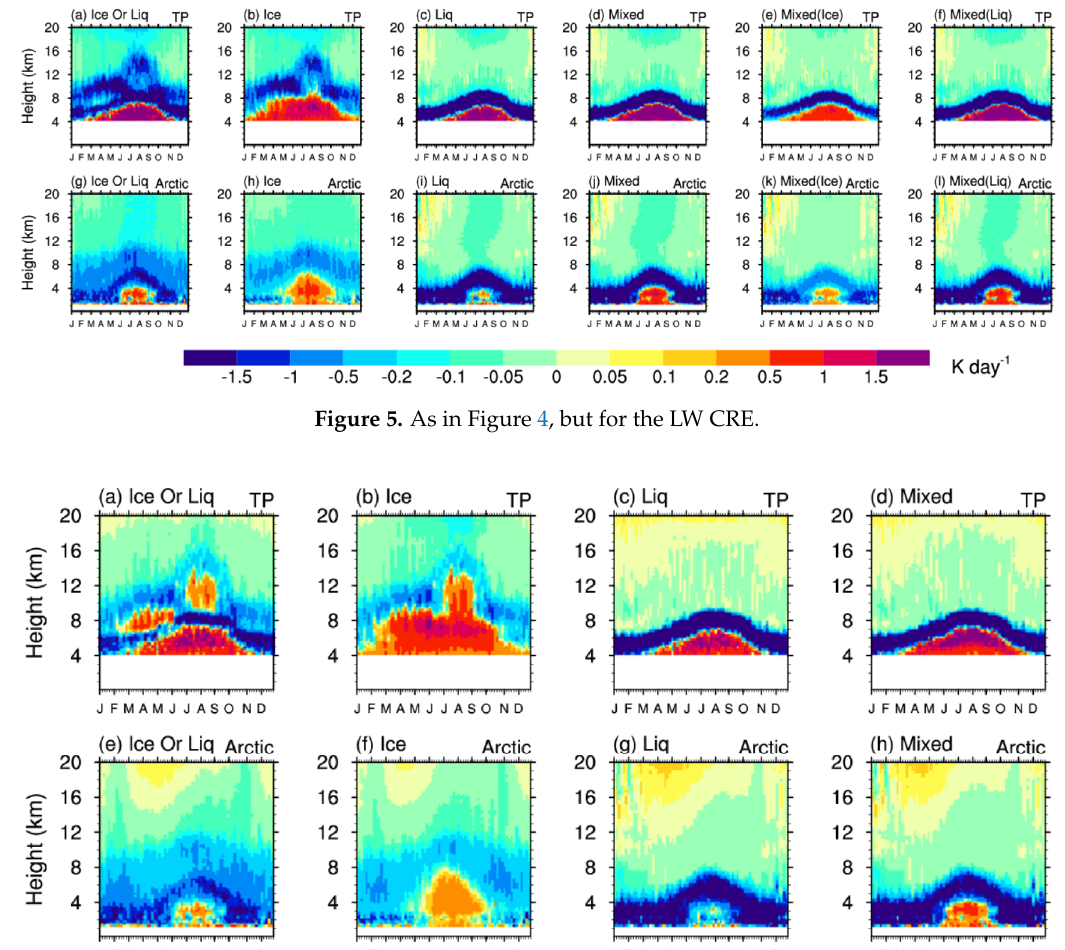
Figure 5. As in Figure 4, but for the LW CRE.